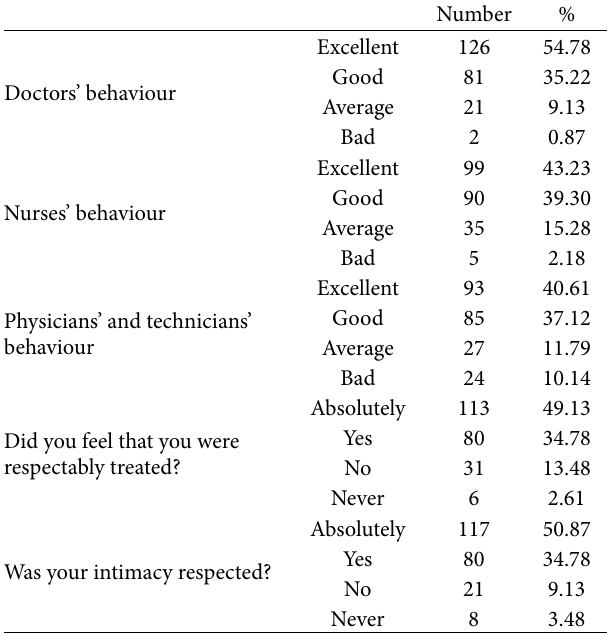
Table 6: Cancer patient satisfaction with human aspects (Hassan II CHU, Fez,